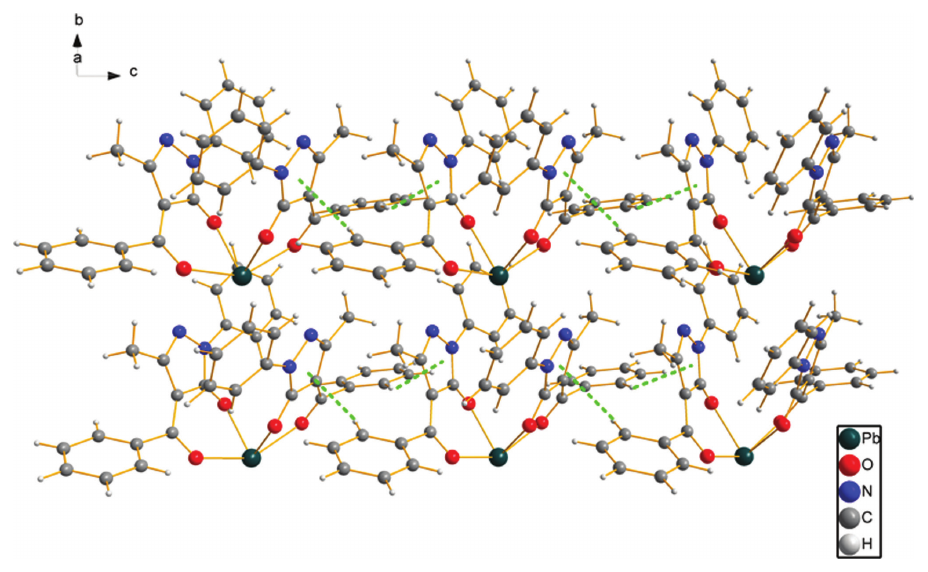
Figure 3 The C-H··· π interactions (shown as green dashed lines) in the title compound.